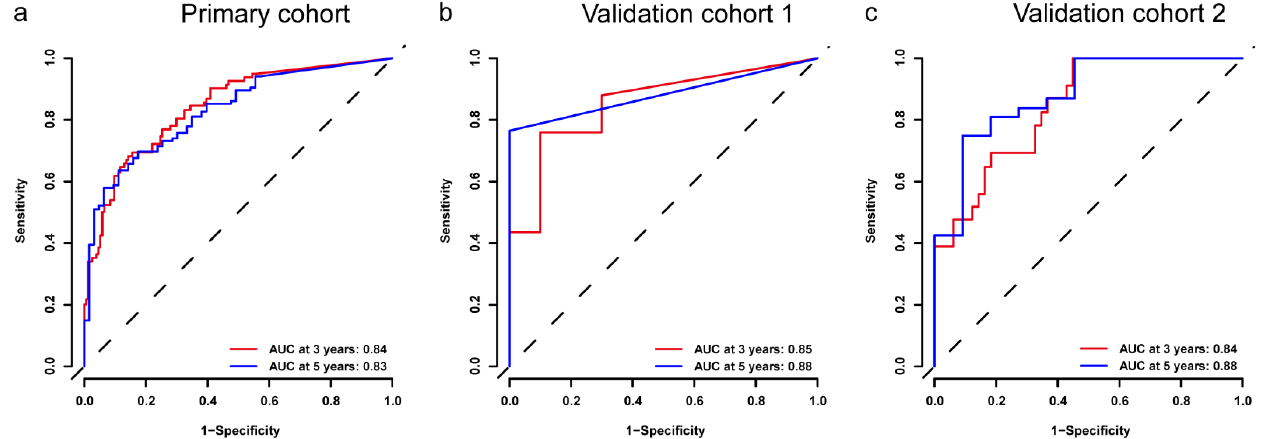
Figure 3. The time-dependence receiver operating characteristic curve (ROC) of DRS-BCR in the primary cohort, validation cohort 1, and validation cohort 2. DRS: deep radiomic signature; AUC: area under the curve. Table 2. Patient